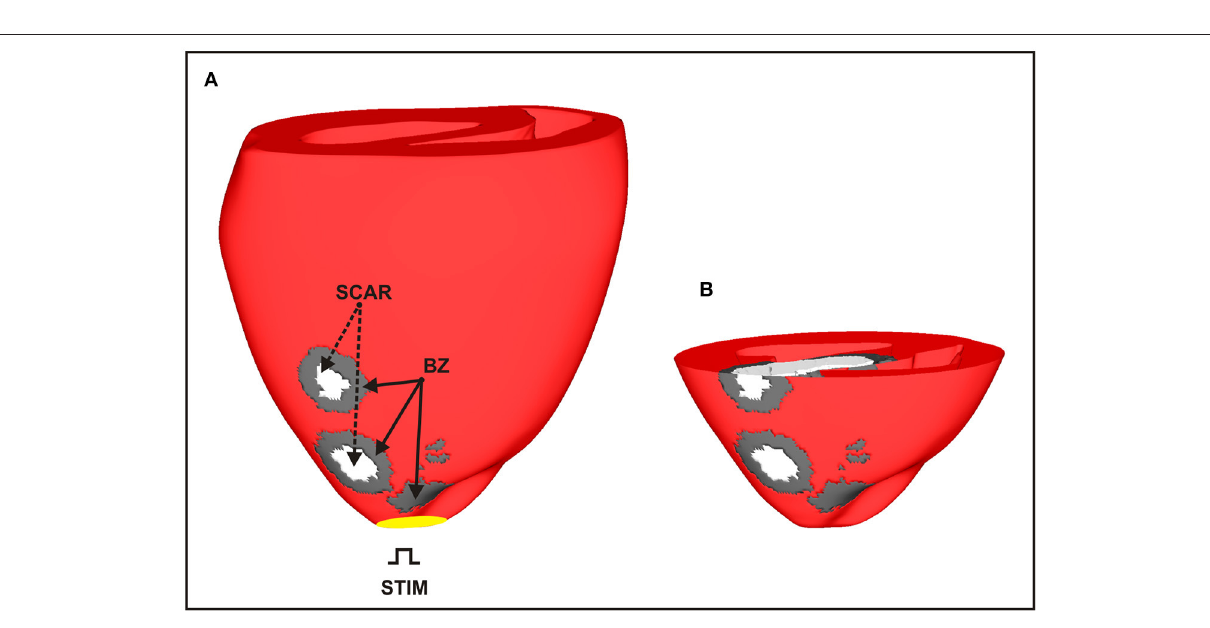
(see Figure 3 ). In both cases, the stimulus was followed by a 1,500-ms pause in order to see whether PVCs would